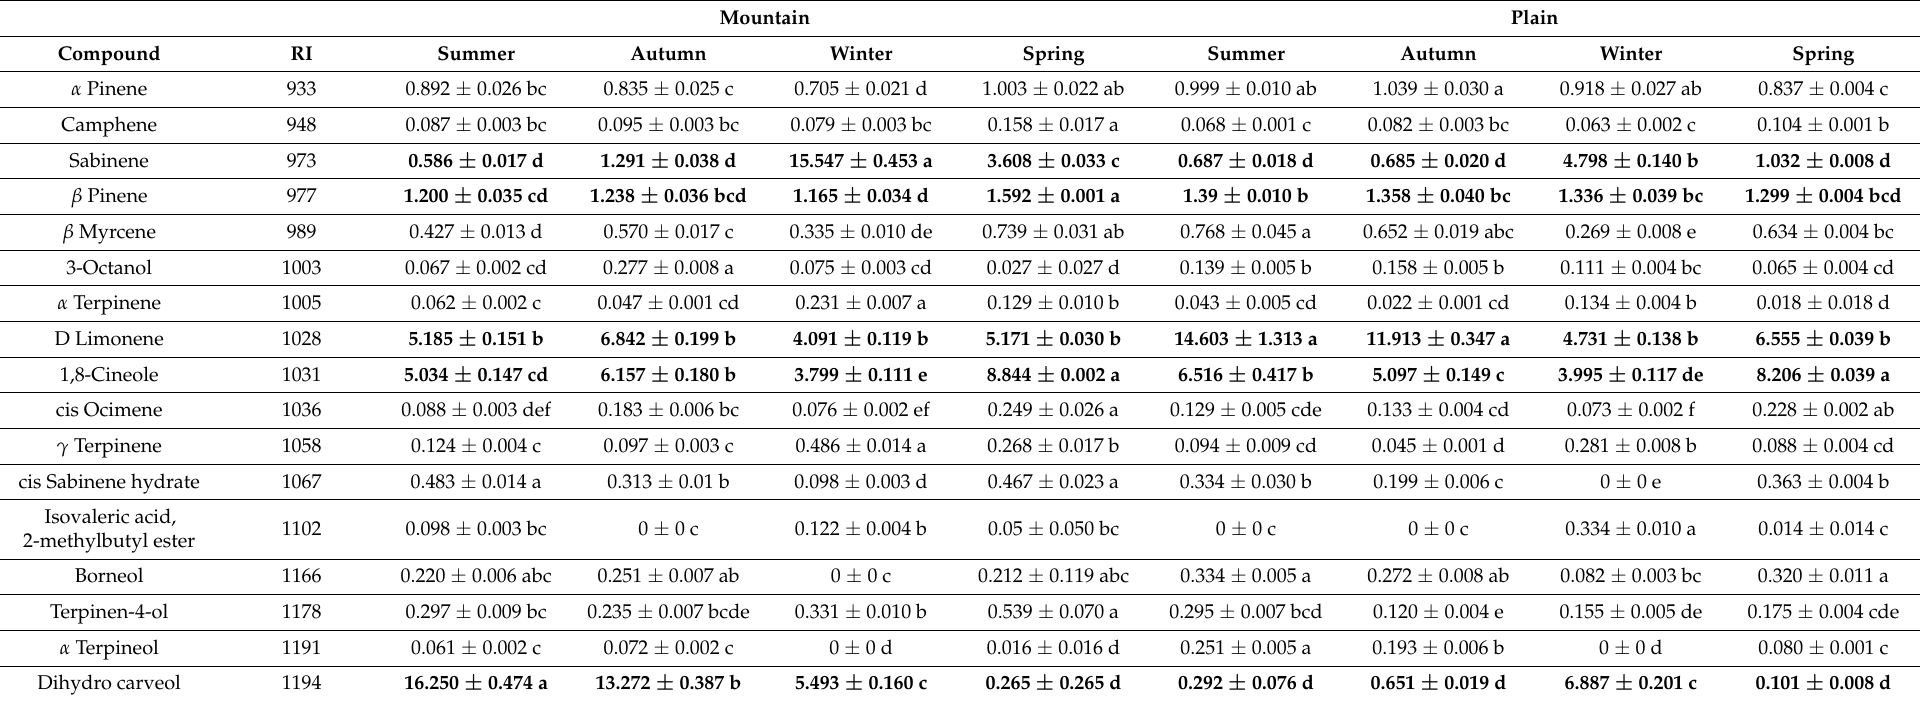
Table 7. Chemical composition (%) of essential oils of spearmint